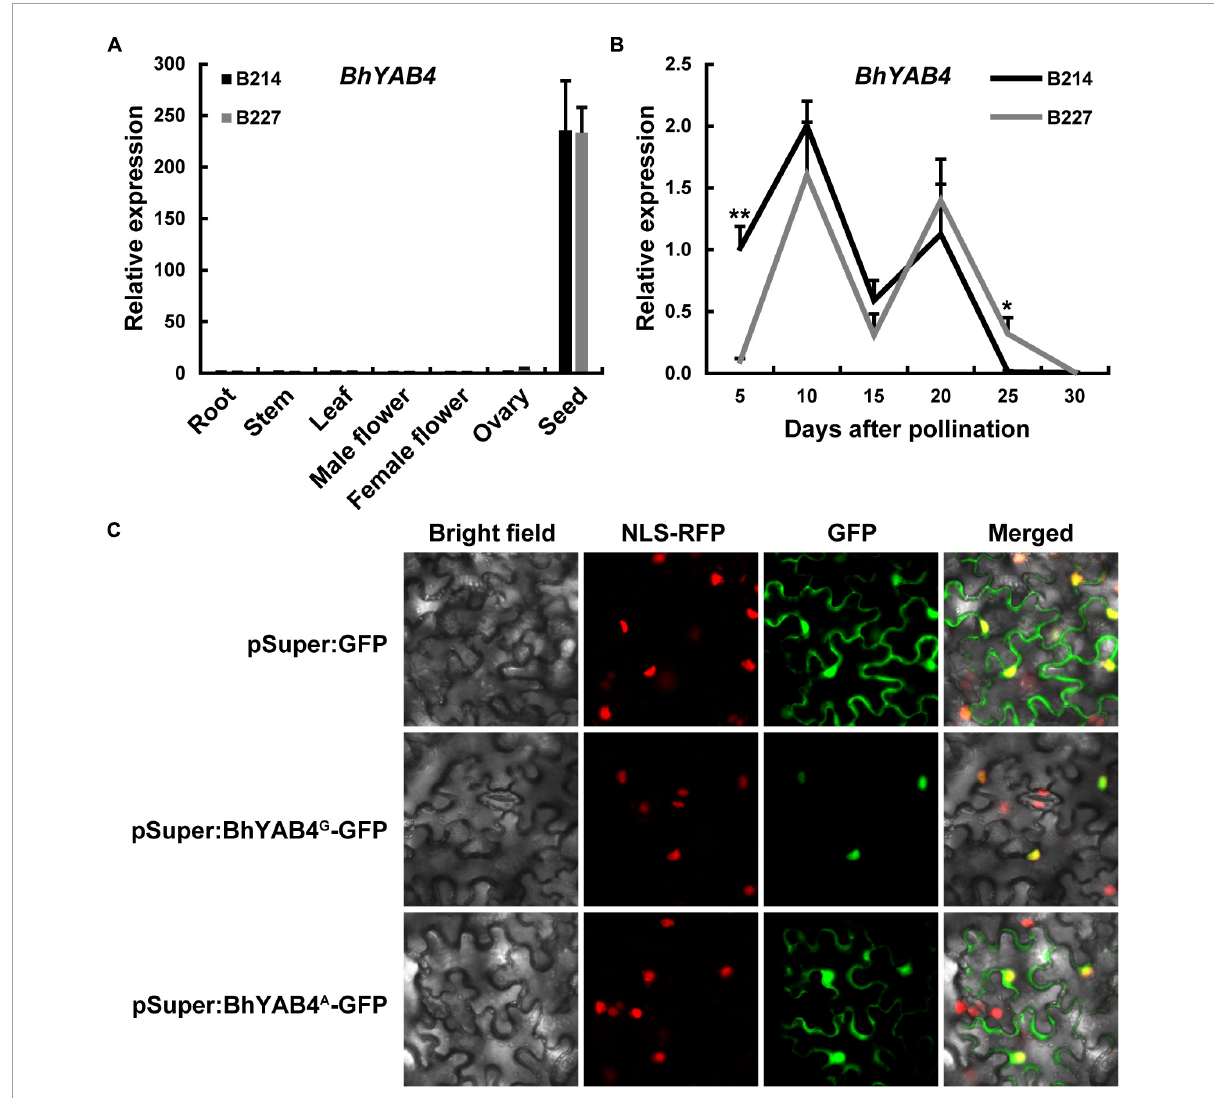
FIGURE4 Expression pattern and subcellular localization of BhYAB4 . (A) Relative expression of BhYAB4 in different tissues of the wax gourd. Values are presented as means ± SD ( n = 3). (B) Relative expression of BhYAB4 in seeds at different developmental stages. Values are presented as means ± SD ( n = 3). * P < 0.05, ** P < 0.01 (Student’s t -test). (C) Subcellular localization of BhYAB4 G and BhYAB4 A